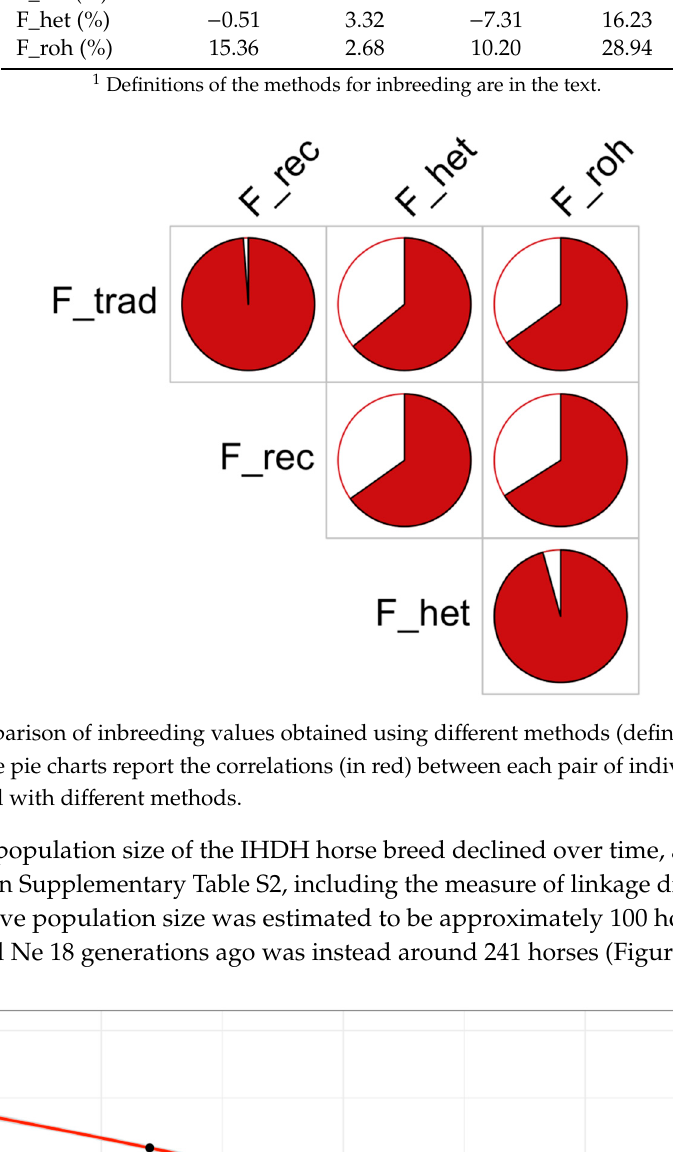
Figure 4. Estimation of genomic effective population size (Ne) traced back to 18 generations ago.